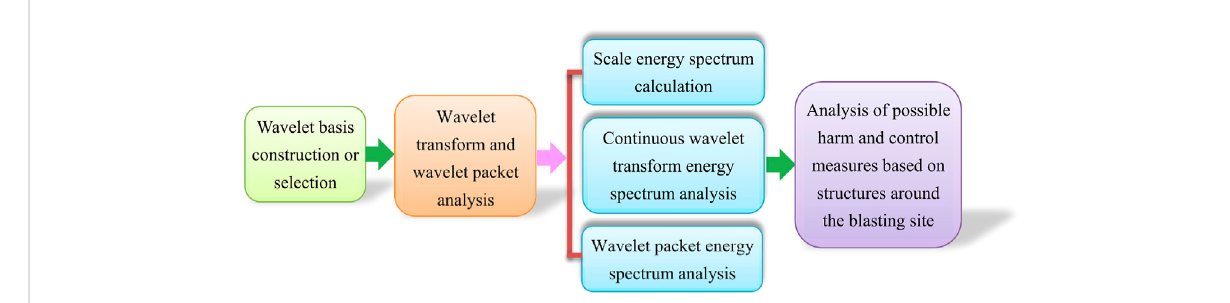
FIGURE 6 Flow chart of time-frequency characteristic analysis of blasting vibration signals.